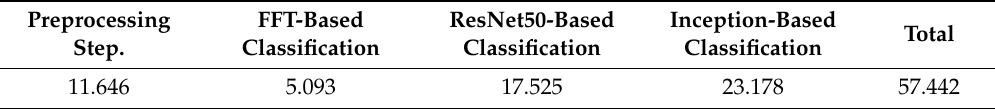
Table 10. Processing time of our proposed method (unit: